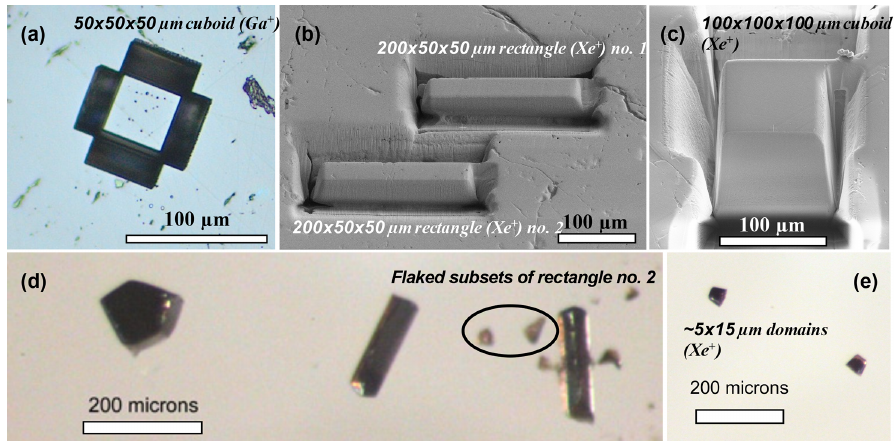
Figure 2. Optical microscopy and secondary electron (SE) imaging of isolated baddeleyite domains in Phalaborwa baddeleyite mount. The small amount of material left to anchor the domains (a–c) is critical in transporting the mount without losing material and in ensuring easy extraction without the need for tungsten weld or complicated and time-consuming micromanipulator usage. Once released from the grain mount, samples can be broken into further subsamples (d) and extensively imaged (e) . All of the FIB-extracted samples used for TIMS analyses, as denoted in Table 1, are imaged